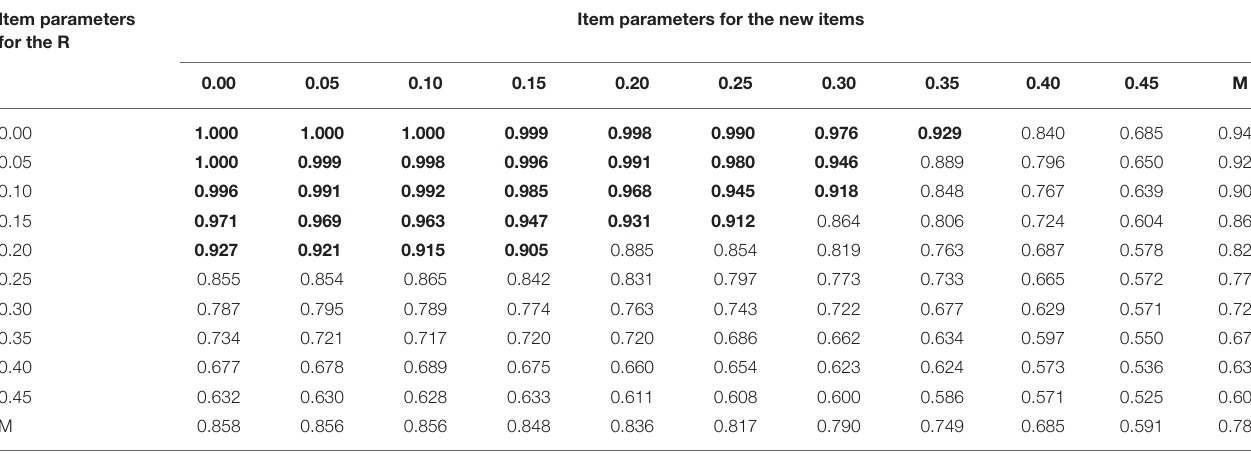
Item parameters for the new items